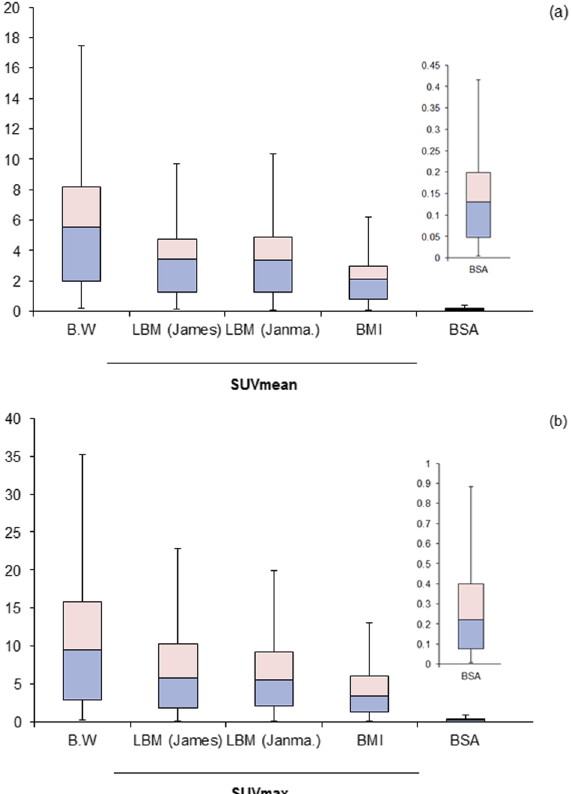
Fig. 3 Normalization of lesion SUV to body mass index, body surface area, lean body mass, and body weight using a SUVmean, b